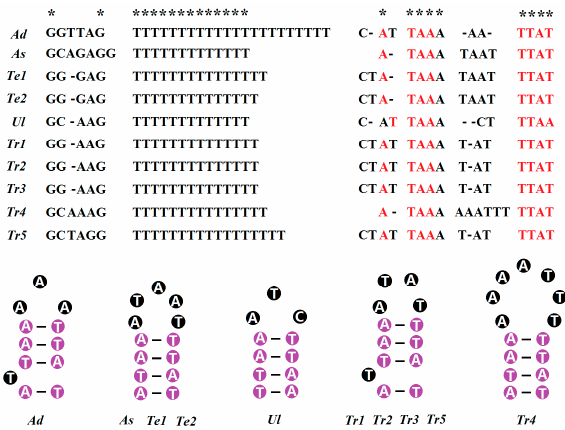
Figure 7. T stretch in the major strand, the abutting flanking regions, and the stem and loop structure formed by the 3’ flanking region in ten Tenebrionidae mitogenomes. * denotes the conserved site. Red letters denote the nucleotide located in the stem of stem — loop structure, white letters with purple circle as background denote nucleotides in the four conserved couplets of the stem, white letters with black circle as background denote variable nucleotides in the stem — loop structure.